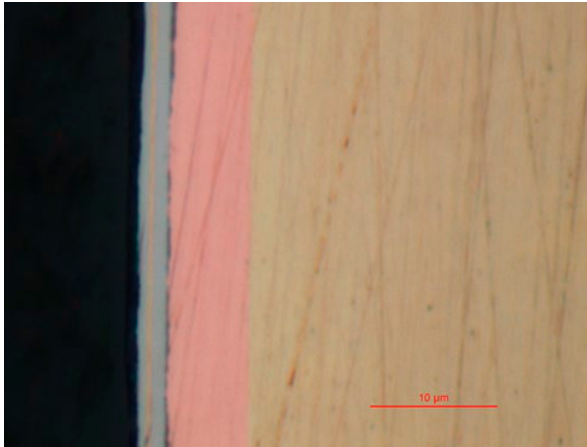
Figure 4. Cross section of typical galvanic deposition analyzed with optical microscope. From left to right it is possible to distinguish: brass substrate, copper, nickel and gold finishing. Before the cut of the sample an additional layer of nickel was deposited on gold to preserve its integrity and sharp edge during the lapping process.